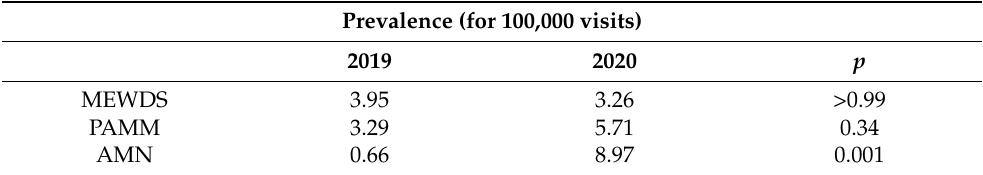
Table 1. Prevalence of acute macular neuroretinopathy (AMN), paracentral acute middle maculopa- thy (PAMM) and multiple evanescent white dot syndrome (MEWDS) in 2019 and 2020 using the